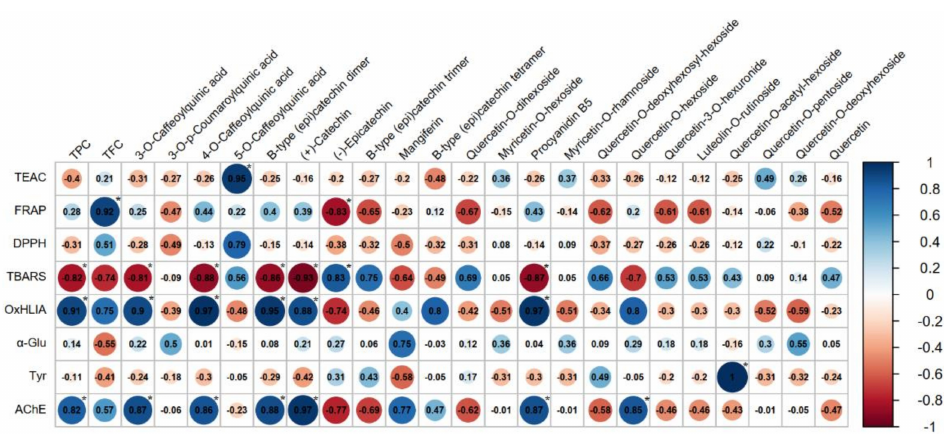
Figure 2. Correlation plot (correlogram) that shows Pearson’s correlation coefficients between chemical constituents of analyzed extracts and total antioxidant capacity and enzyme-inhibitory activities of the extracts. Red color represents negative correlation (values from 0 to − 1), which indicates an inverse proportional relationship between the compared variables, while the blue color represents positive correlation (values from 0 to +1), which indicates a direct proportional relationship between the compared variables. The e diameter of each dot and the intensity of the colors indicate the strongness of correlation (increased values of Pearson’s correlation coefficients). Asterisk (*) indicates the statistical significant results ( p